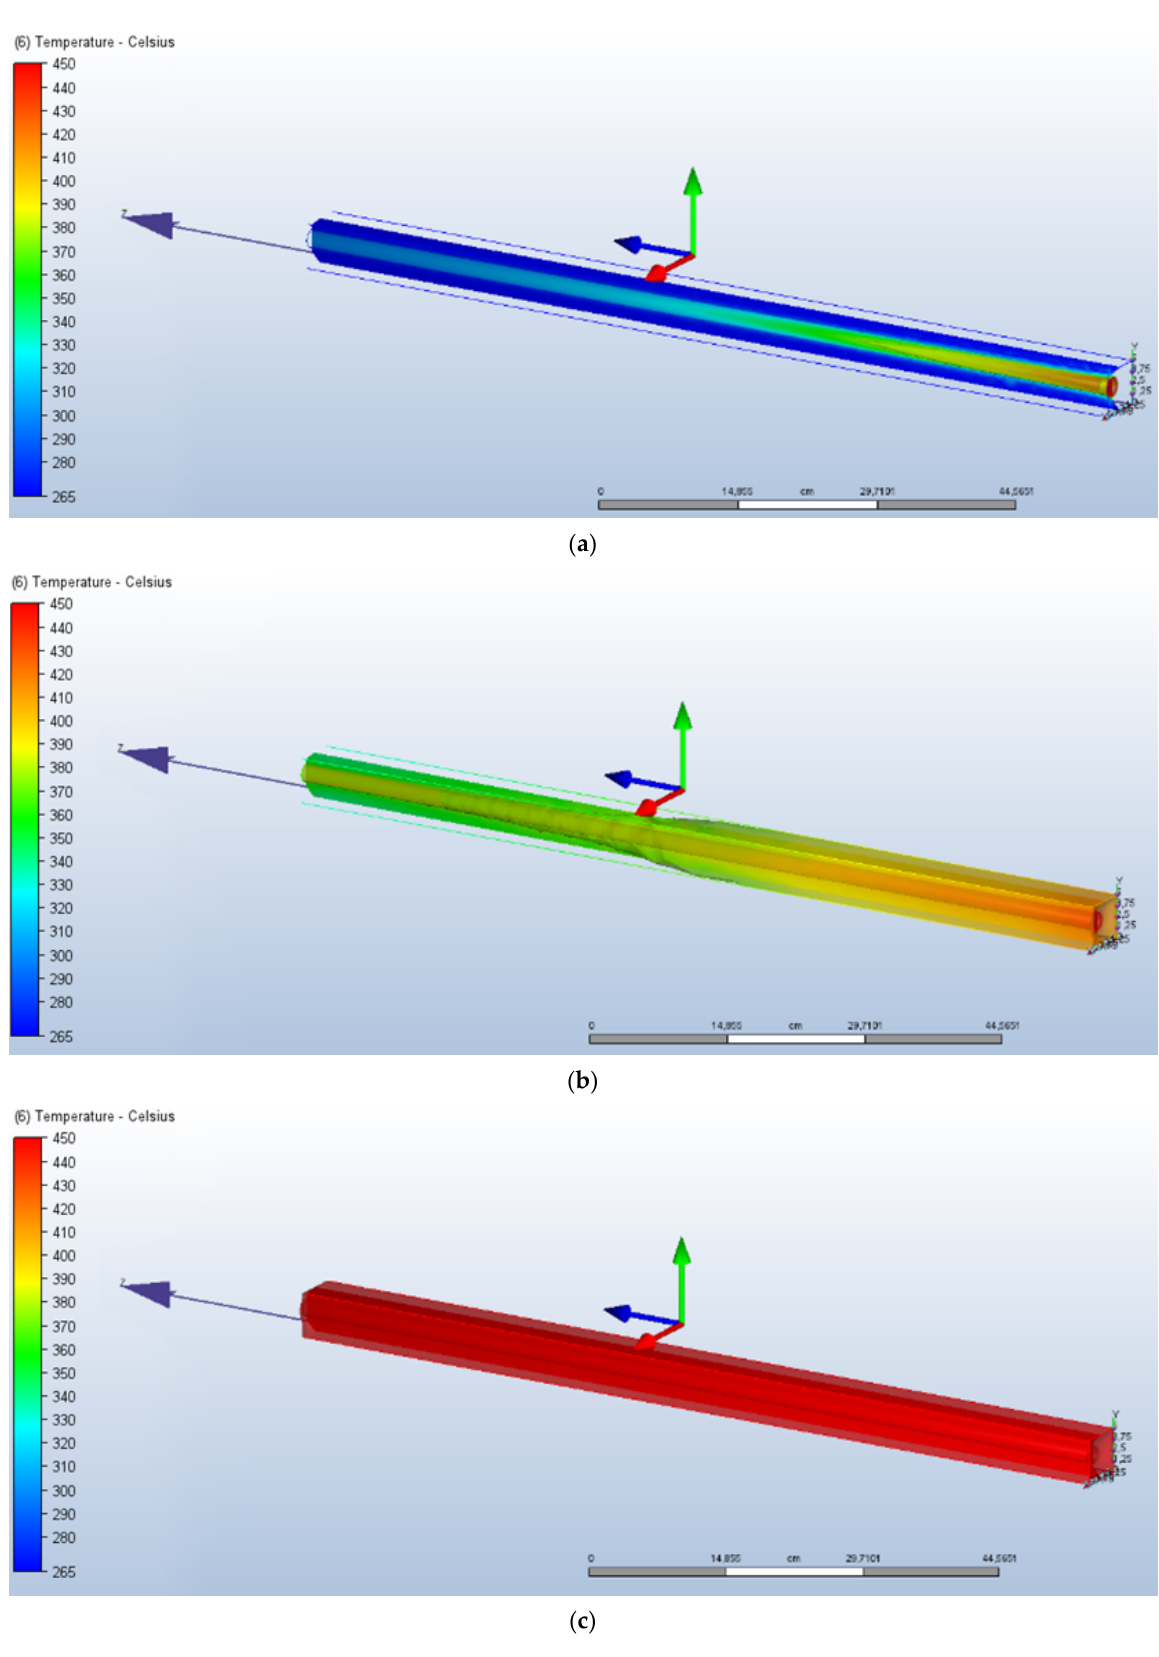
Figure 5. Computational fluid dynamics of the proposed concrete block: ( a ) initial charge, ( b ) mid-charge, ( c ) full charge.